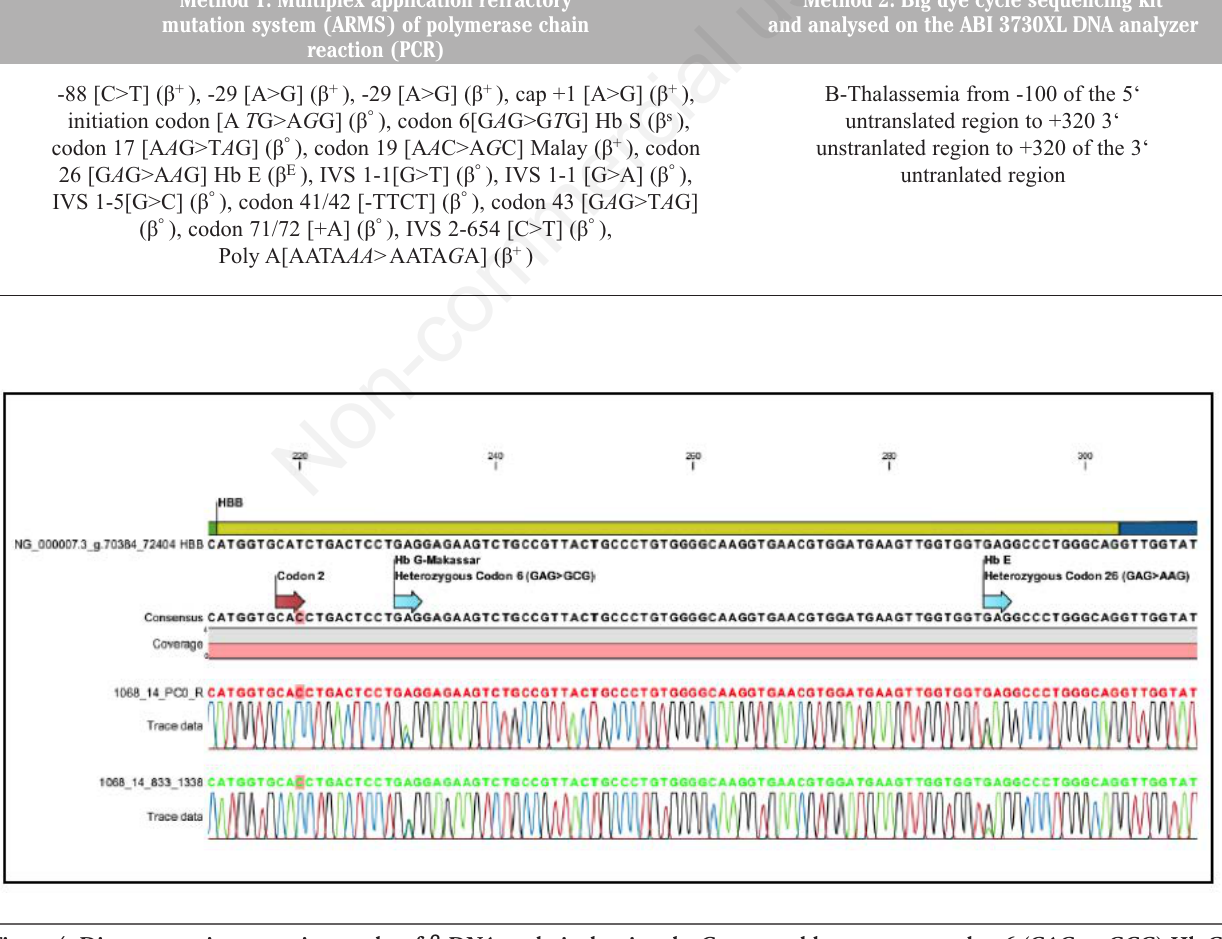
DNA analysis showing the Compound heterozygous codon 6 (GAG -> GCG) Hb G- E) mutations. β β